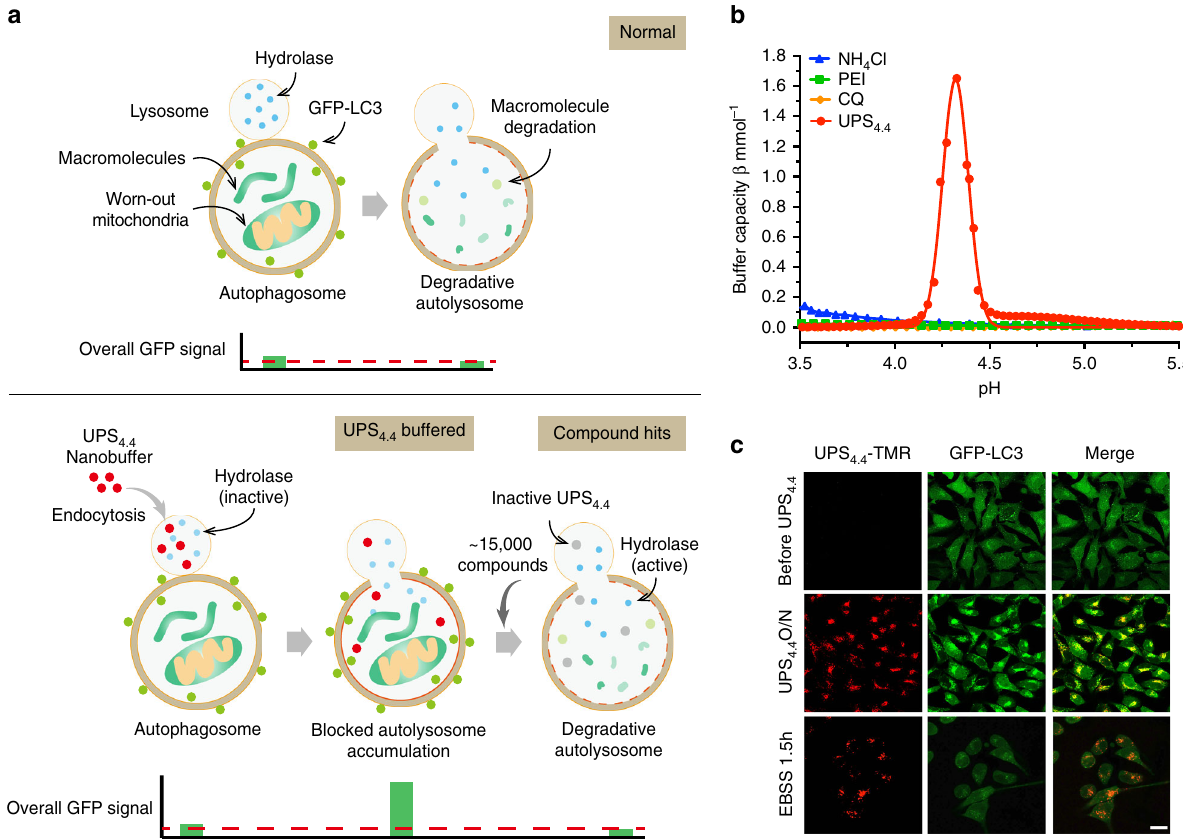
Fig. 1 A UPS-enabled compound screen design that allows for discovery of agents that promote maturation of autophagosomes to degradative autolysosomes. a A schematic showing the design of a quantitative high-throughput cell-based assay for agents that promote maturation of autophagosomes to degradative autolysosomes. Under normal conditions, GFP-LC3 is degraded in autolysosomes resulting in a mild decrease in total fl uorescent intensity of GFP signals. UPS 4.4 -buffered autolysosomes have a pH environment that is not optimal for hydrolase activation. In consequence, GFP-LC3 accumulates in the cytosol resulting in a detectable increase in GFP fl uorescence intensity as compared to controls. Compounds that promote autophagic fl ux and lysosomal function overcome the buffering effect of UPS 4.4 and transition the accumulated defective autolysosomes into degradative autolysosomes. This results in a reduction in GFP fl uorescence intensity that is reproducibly detectable in a high-throughput setting. b Buffer capacity ( β ) of UPS 4.4 , NH 4 Cl, chloroquine (CQ) and polyethylenimine (PEI) was plotted as a function of pH. c Representative images showing the effect of UPS 4.4 -TMR treatment and a subsequent nutrient-starvation on GFP-LC3 puncta accumulation. Scale bar, 20 μ